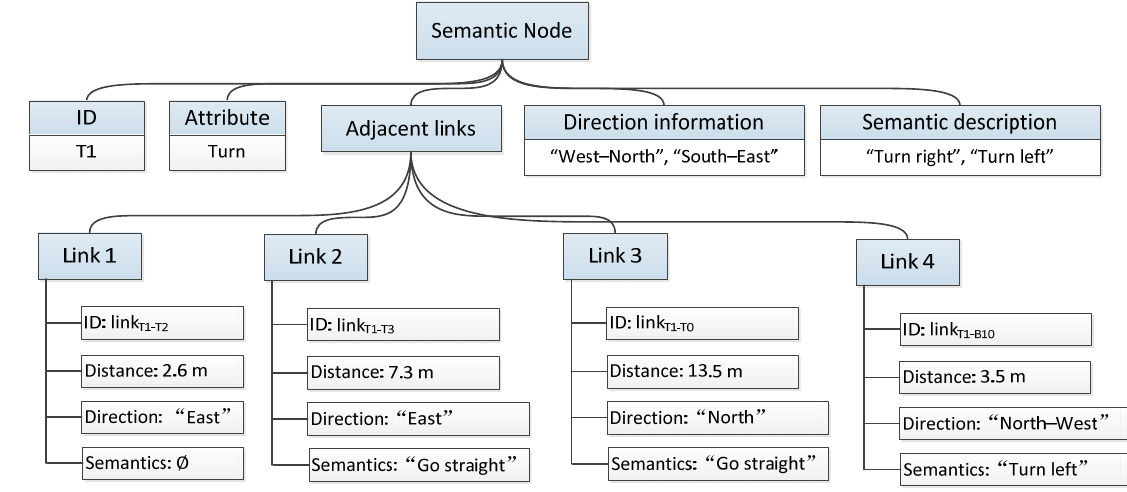
Figure 3. The semantic-rich information of node T1.